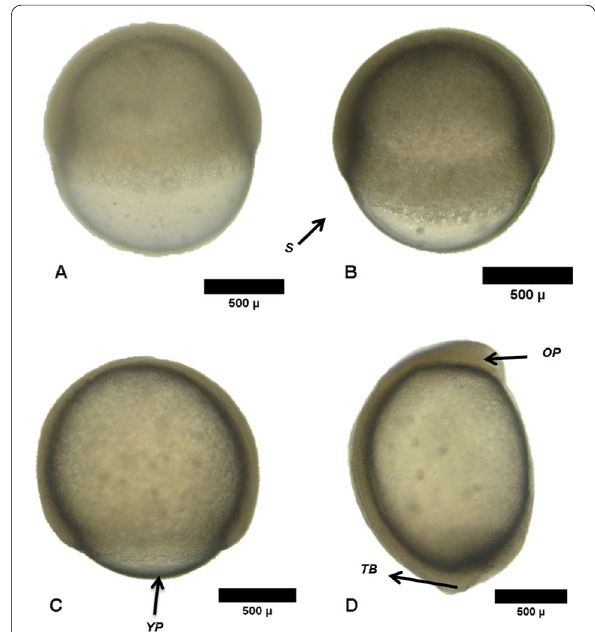
Fig. 5 Prochilodus magdalenae , developmental gastrula period from 50% e.b.: A 50% epiboly, B 75% epiboly, C 90% epiboly, and D bud stage. Abbreviations: OP: optic primordium; S: shield; TB: tail bud; YP: yolk